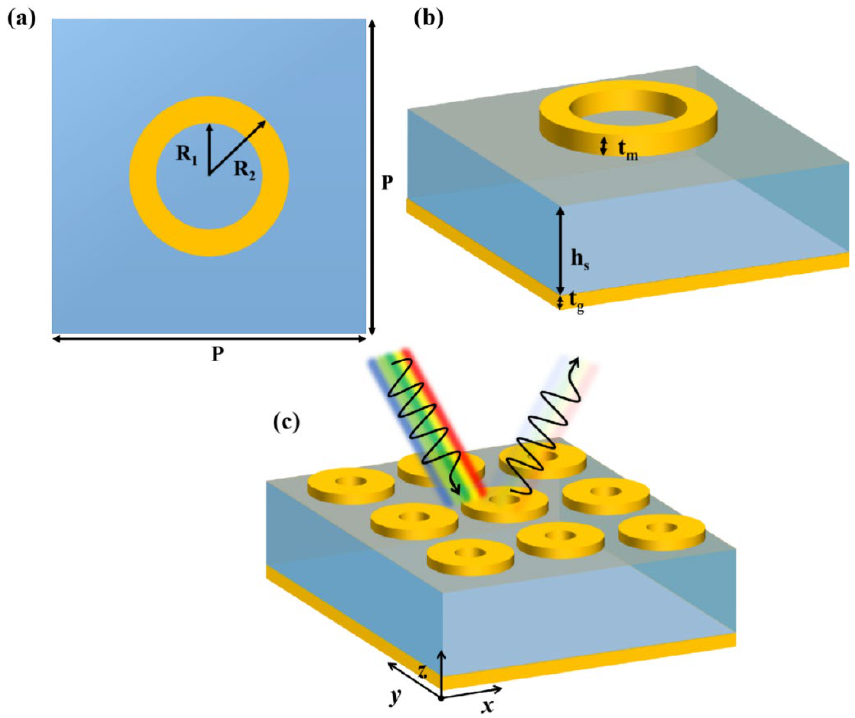
Figure 1. Schematic depiction of the proposed nano-absorber: ( a ) front outlook of the proposed meta-cell composed of nano circular ring of nickel (Ni), ( b ) side view of the proposed unit cell of the nano circular ring of nickel (Ni), and ( c ) 3D periodic array of the unit cells of the of nano circular ring of nickel (Ni).